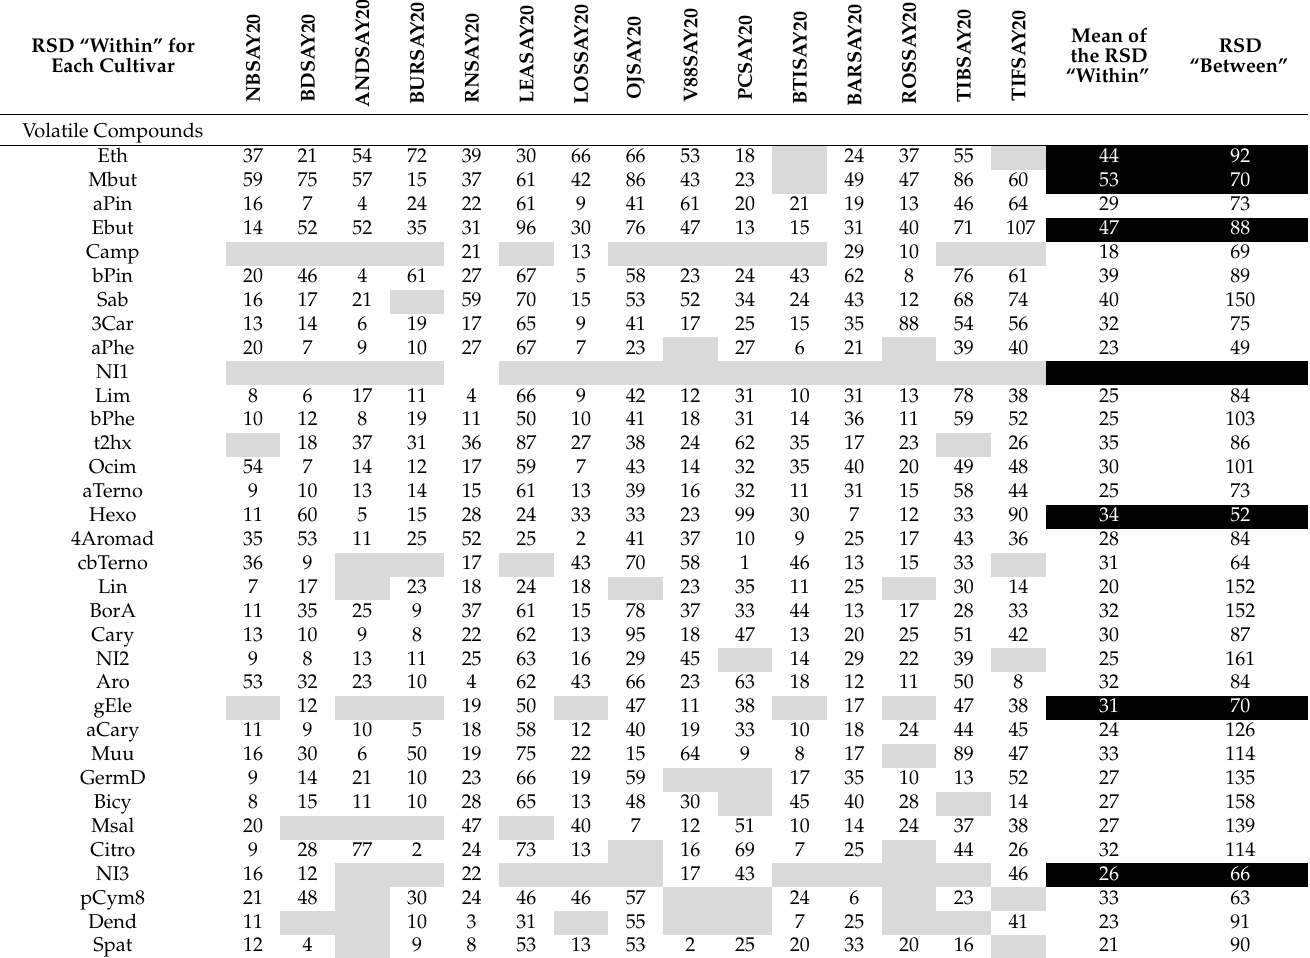
Table 2. Stability of peak areas, expressed by the relative standard deviation (RSD).